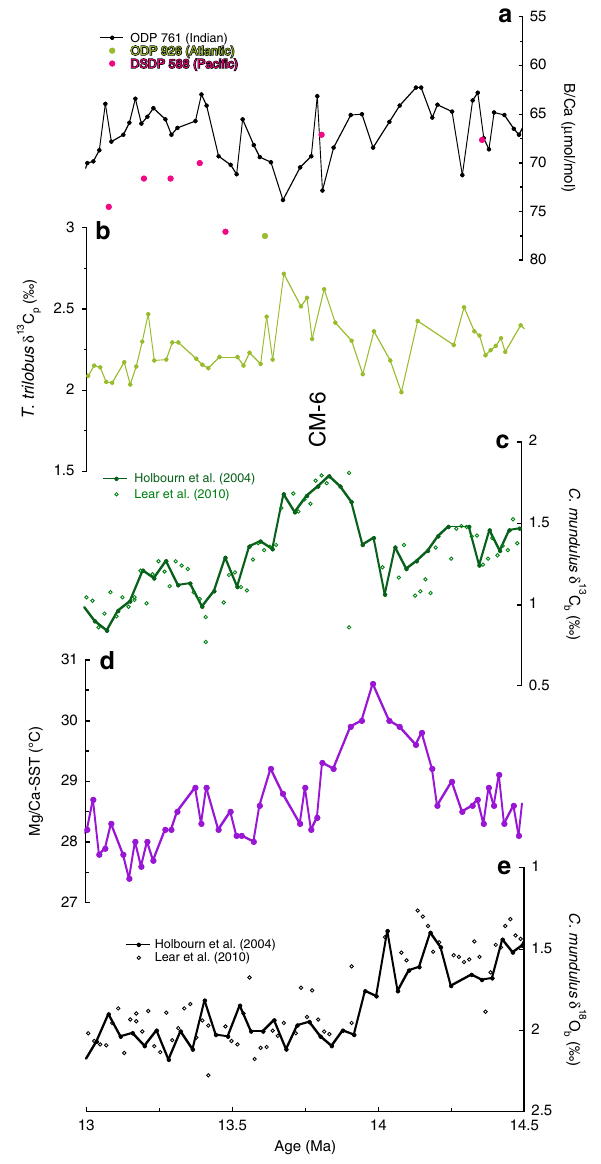
Fig. 2 Isotopic and trace metal records across CM6. a Planktic foraminifera T. trilobus B/Ca from Indian (ODP 761), Paci fi c (DSDP 588), and Atlantic Oceans (ODP 926 alongside ( b ) planktic foraminiferal carbon isotope record from ODP site 761. c Benthic foraminiferal carbon isotopes from ODP site 761 14,21 . d Mg/Ca-SST estimates from ODP site 761. e Benthic foraminiferal oxygen isotopes from ODP site 761 14,21